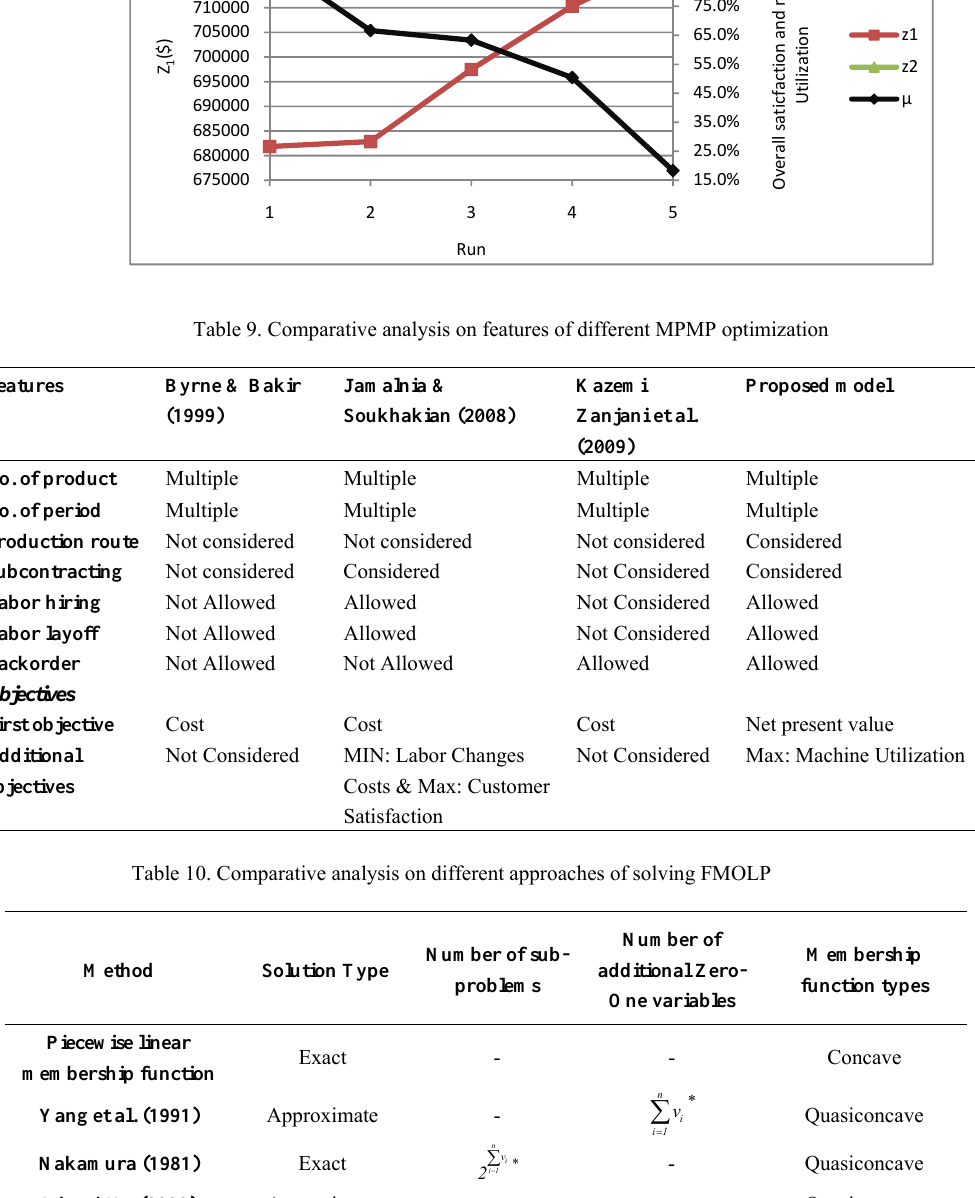
* v i represents the number of intersections between concave and convex functions.